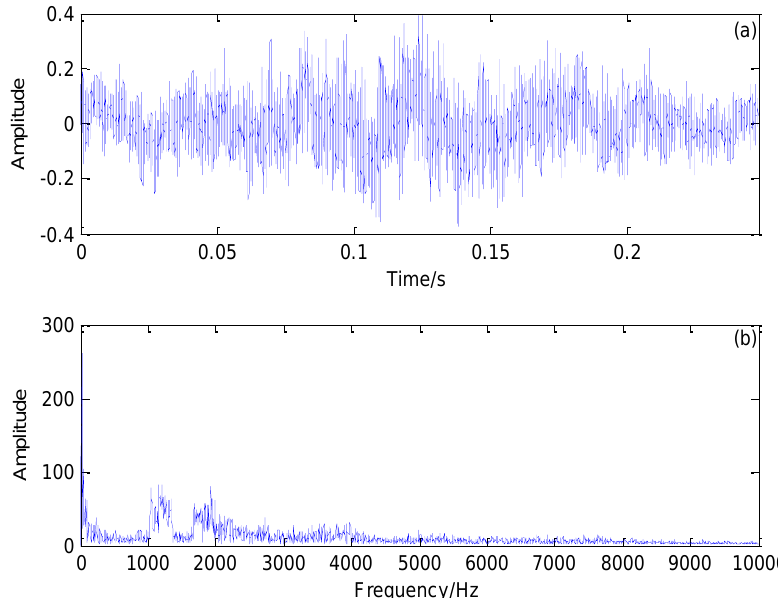
Figure 10. Outer race fault signal of the locomotive bearing under the loading of 3 t: ( a ) time domain signal and ( b ) its